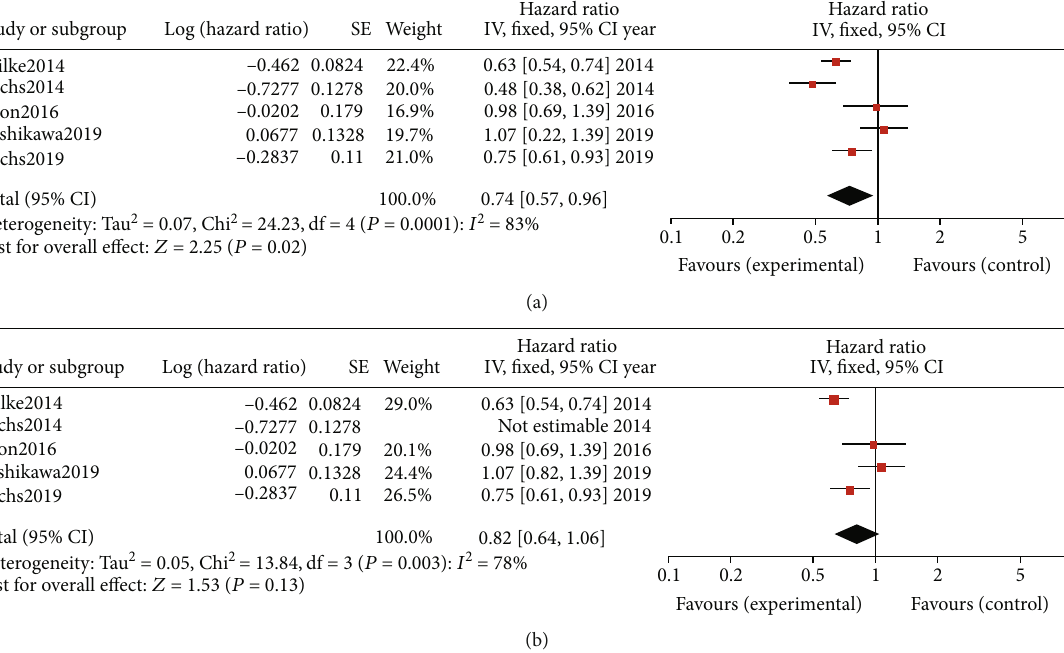
Figure 3: (a) Pooled analysis of progression-free survival (PFS) comparing the application of ramucirumab (RAM) alone or plus chemotherapy with the control (placebo or chemotherapy). (b) Pooled analysis of PFS comparing the application of RAM alone or plus chemotherapy with chemotherapy